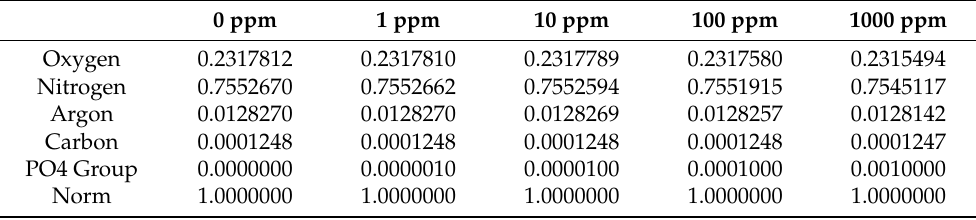
Figure 9. Cluster configuration vs. PO4 Group ppm. Table 3. Air vs. PO4 virion